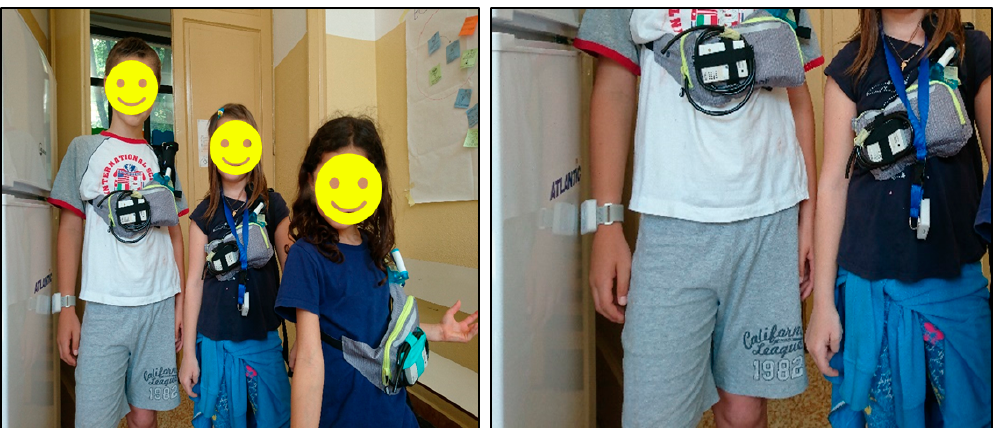
Figure 1. Picture of children wearing the shoulder bag equipped with a micro-aethalometer, model AE51. GPSs were worn as wristwatch or necklace.